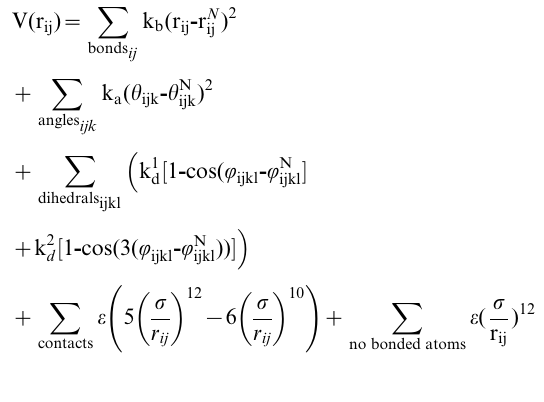
where the last two terms correspond respectively to attractive and denotes the native distance between repulsive interactions. r N ij atoms i and j along the sequence. The topology of the chain is described by the native angle h N between the bonds connecting ijk describe the atom pairs ij and jk , and the native dihedrals Q N ijkl angle between the planes defined by atoms ijk and jkl . The strength